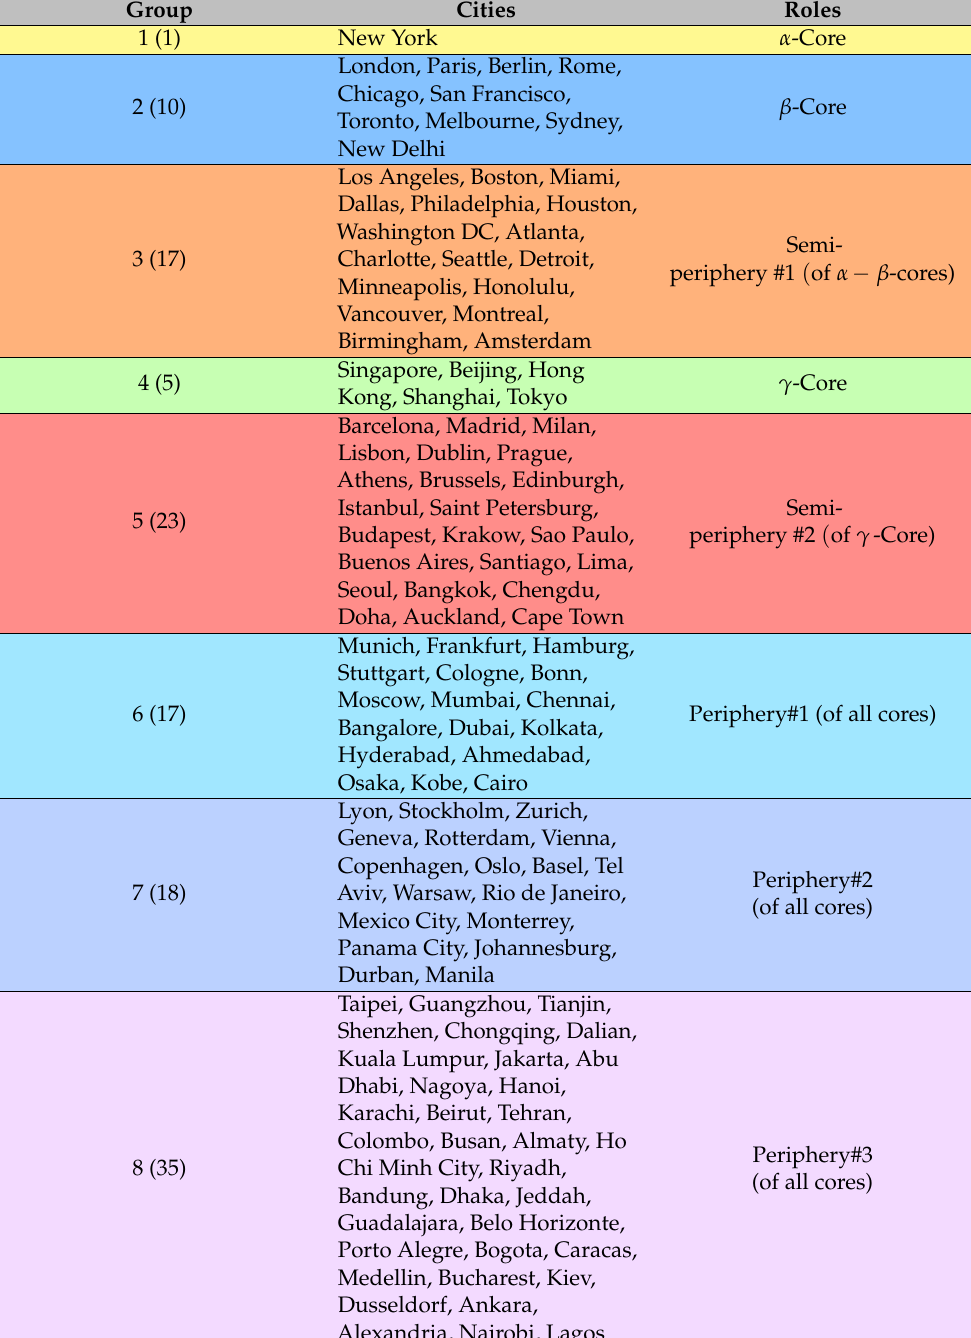
Note: Colors represent groups in Figure